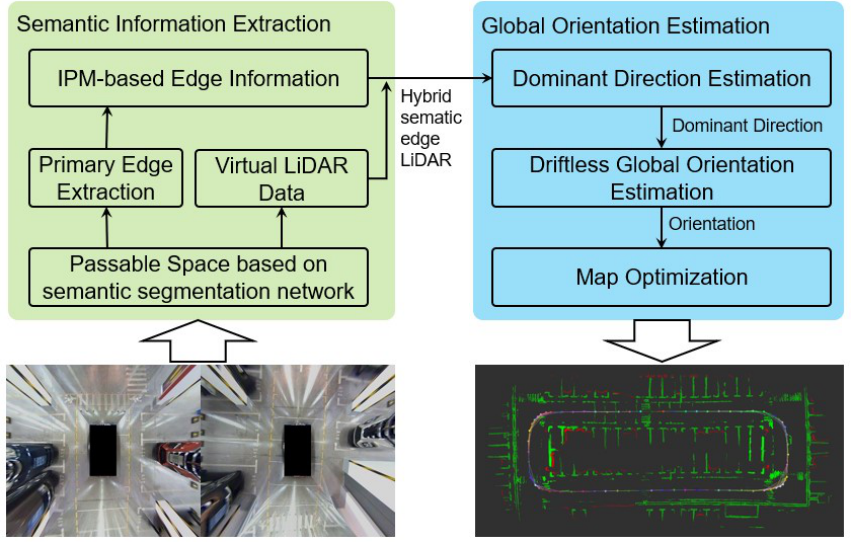
Figure 1. Semantic-structure-aware global orientation estimation